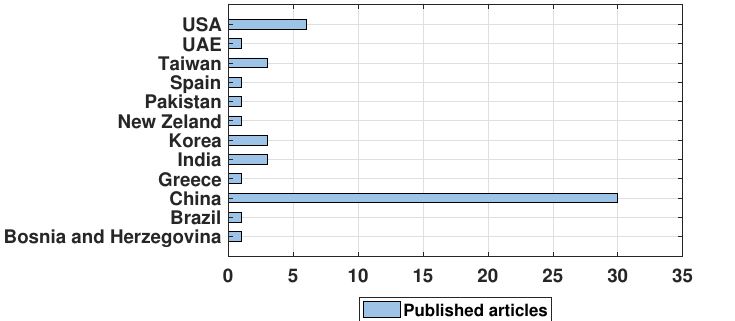
Figure 7. Development by country.